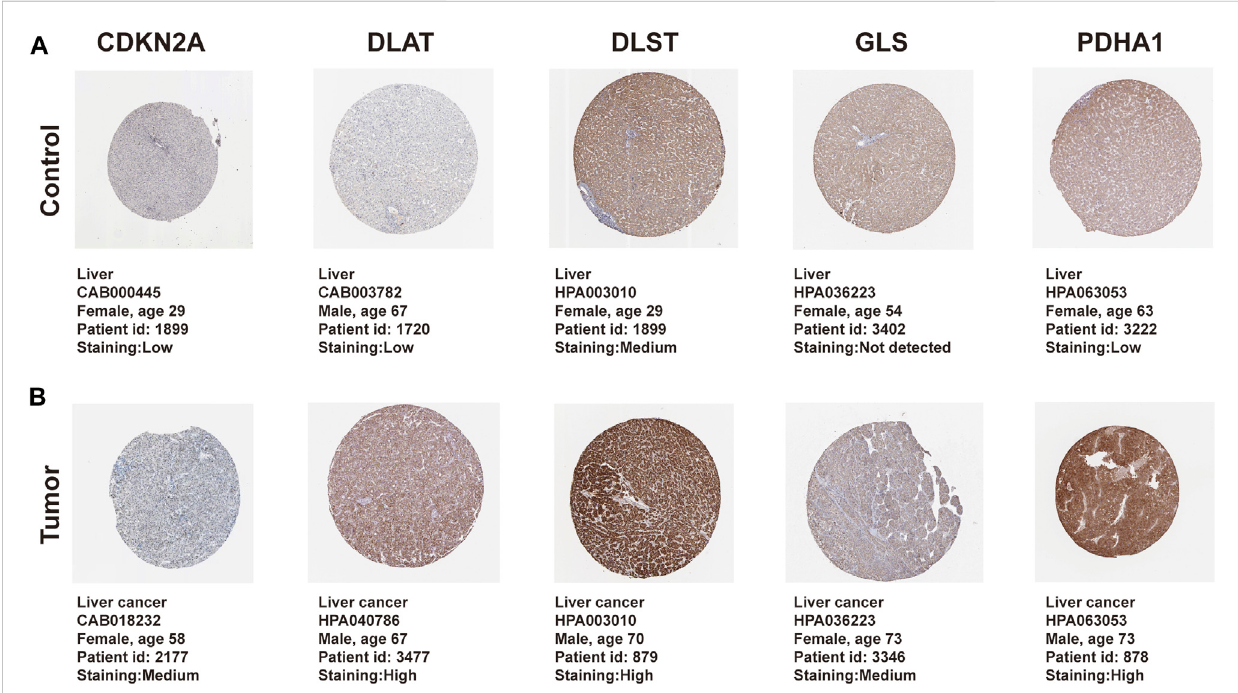
FIGURE 8 Protein differential expression of prognostic CRGs in normal liver and HCC tissue. (A) Protein expression of prognostic CRGs in normal liver. (B) Protein expression of prognostic CRGs in HCC tissue. Immunohistochemical data were obtained from the Human Protein Atlas (×200 magni fi